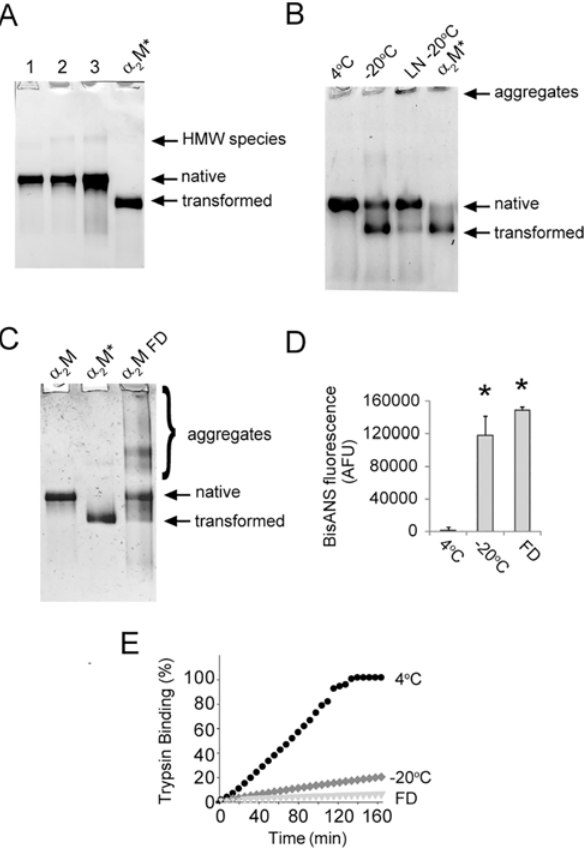
Fig 1. The effects of storage temperature on the conformation of purified α 2 M in PBS/Az. Images of native PAGE (3 – 8% Tris-acetate) gels showing α 2 M (A) freshly purified in PBS/Az (lane 1), after storage in PBS/Az (4°C, 4 months) (lane 2) and after storage in PBS/Az (4°C, 8 months) (lane 3). In all samples, there is a small amount of higher molecular weight (HMW) species present; (B) in PBS/Az (4°C or -20°C, 10 days). Also shown is α 2 M in PBS/Az after rapid freezing in liquid nitrogen (LN) and subsequent storage (-20°C, 10 days), and (C) in PBS/Az (4°C, 2 months) or after freeze-drying (FD) and storage (-20°C, 10 days). In images (A-C) the position of transformed α 2 M ( α 2 M * ; generated by treatment with 400 mM NH 4 Cl in PBS overnight) is shown. (D) bisANS fluorescence measurements for α 2 M in PBS/Az (4°C, -20°C, or freeze dried and stored at -20°C, all for 10 days). The results shown are the mean bisANS fluorescence (n = 3 ± SD) in arbitrary fluorescence units (AFU). (E) Trypsin activity assay showing the conversion of BAPNA to p-nitroaniline by trypsin- α 2 M complexes. For this assay α 2 M was stored as described in (D). * Denotes significant increases in bisANS fluorescence as a result of storing native α 2 M at -20°C, or FD compared to a matched α 2 M sample stored at 4°C (Student ’ s t-test p <